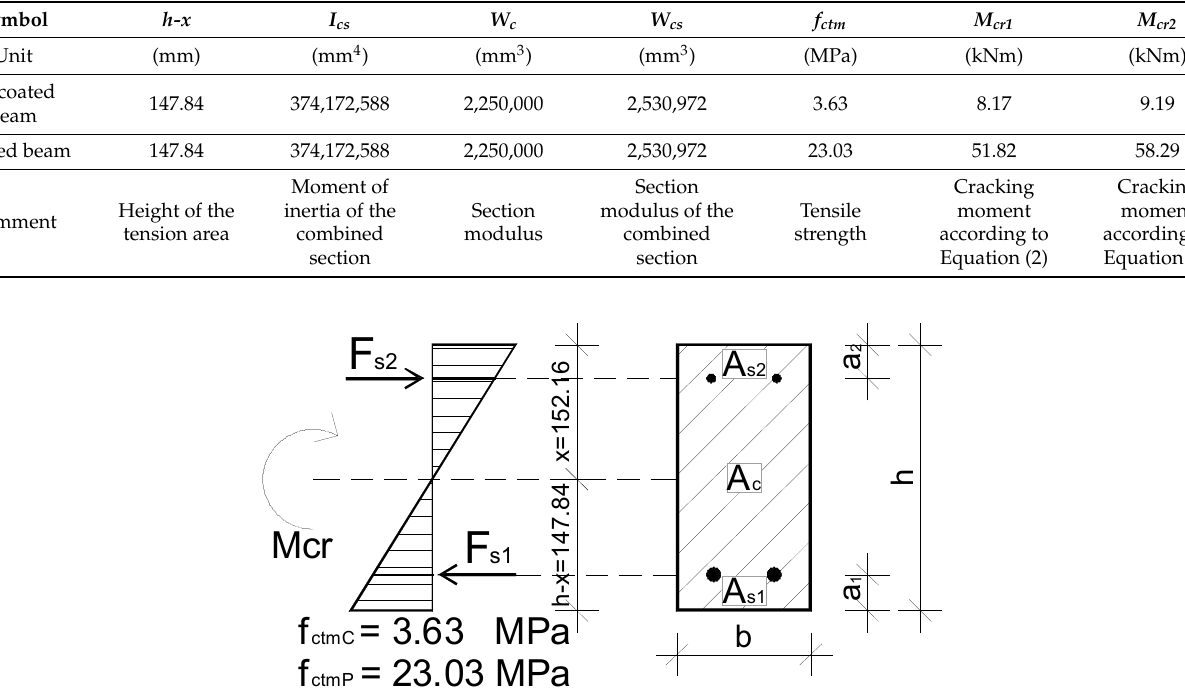
Figure 16. Actual concrete stress diagram—transition between phases I and II. The obtained values of cracking moments for the polyurea-coated beams are over